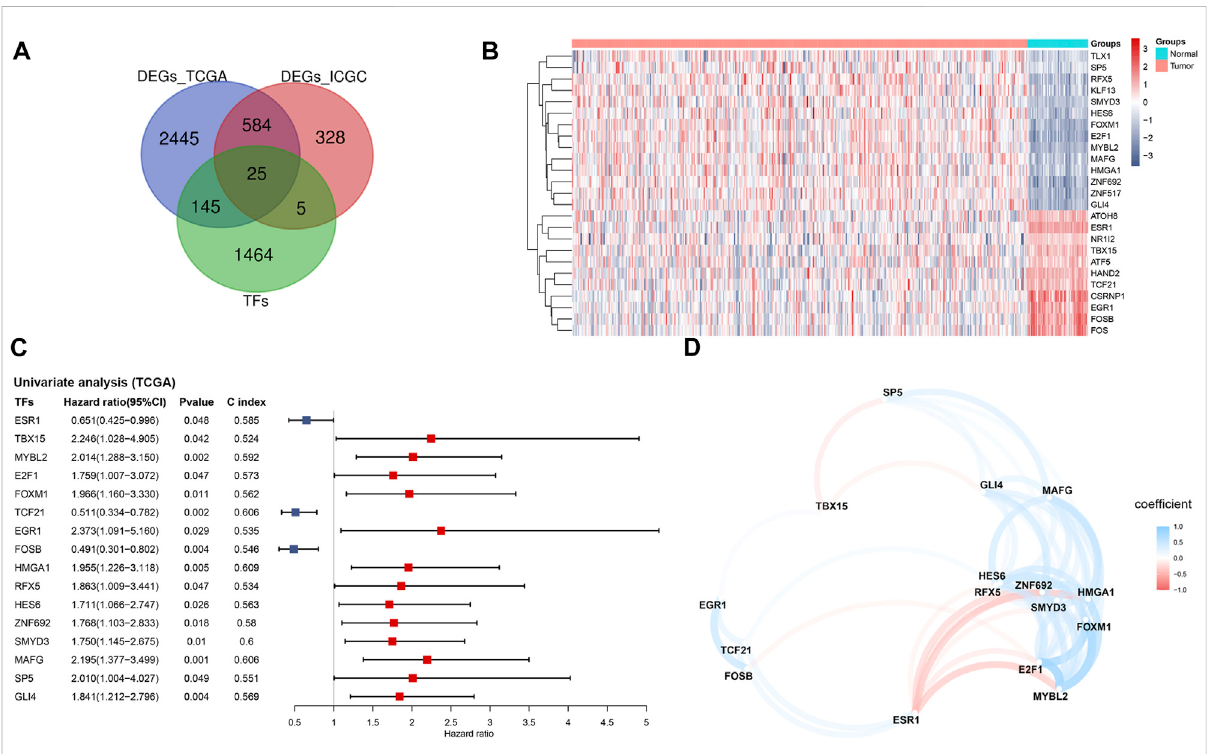
FIGURE 1 Identi fi cation of prognosis-related TFs in HCC based on the TCGA cohort (A) Venn diagram of differentially expressed TFs between tumor and adjacent normal tissues shared in the TCGA and ICGC cohorts (B) Heatmap of the 25 overlapping TFs in the TCGA cohort (C) Forest plot of the prognosis-related TFs based on univariate Cox regression analysis (D) The correlation network of prognosis-related TFs. TFs, transcription factors; TCGA, The Cancer Genome Atlas; ICGC, International Cancer Genome